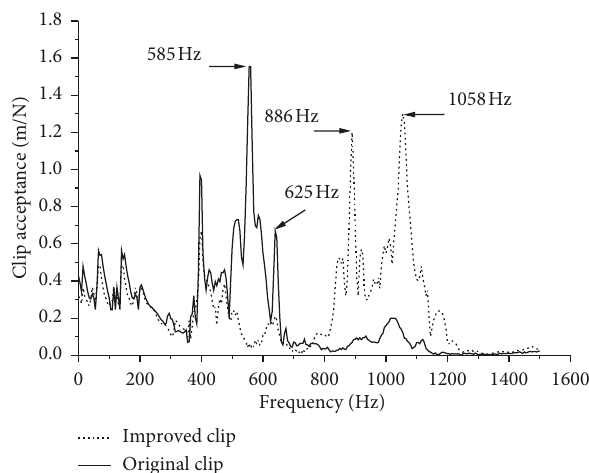
Figure 21: Frequency contents of the response test.